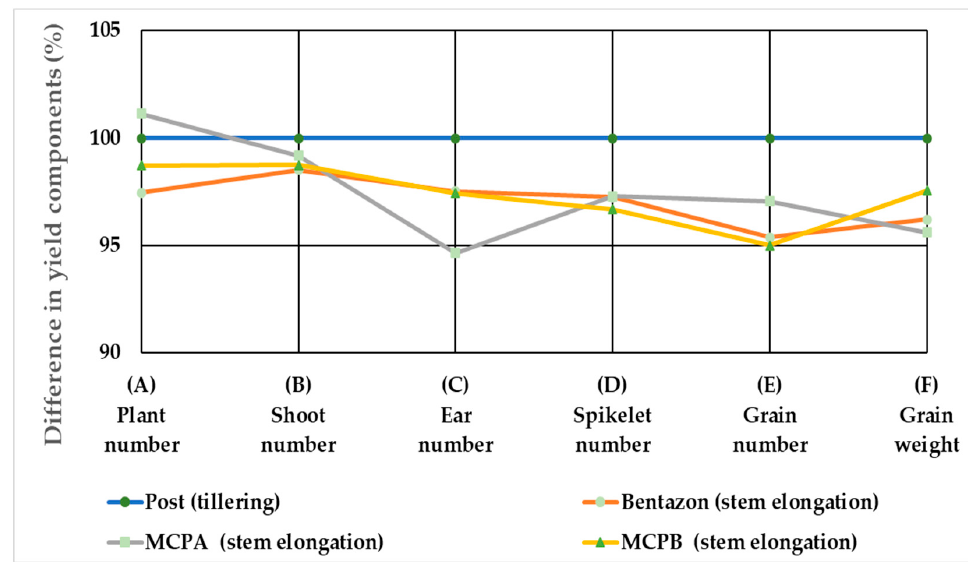
Agronomy 2022 , 12 , x FOR PEER REVIEW 20 of 29 Figure 6. The effect of the timing of post-emergence treatments applied after pre-emergence treat- ments for the development of winter wheat ( Triticum aestivum L.), over an average of 2 years.